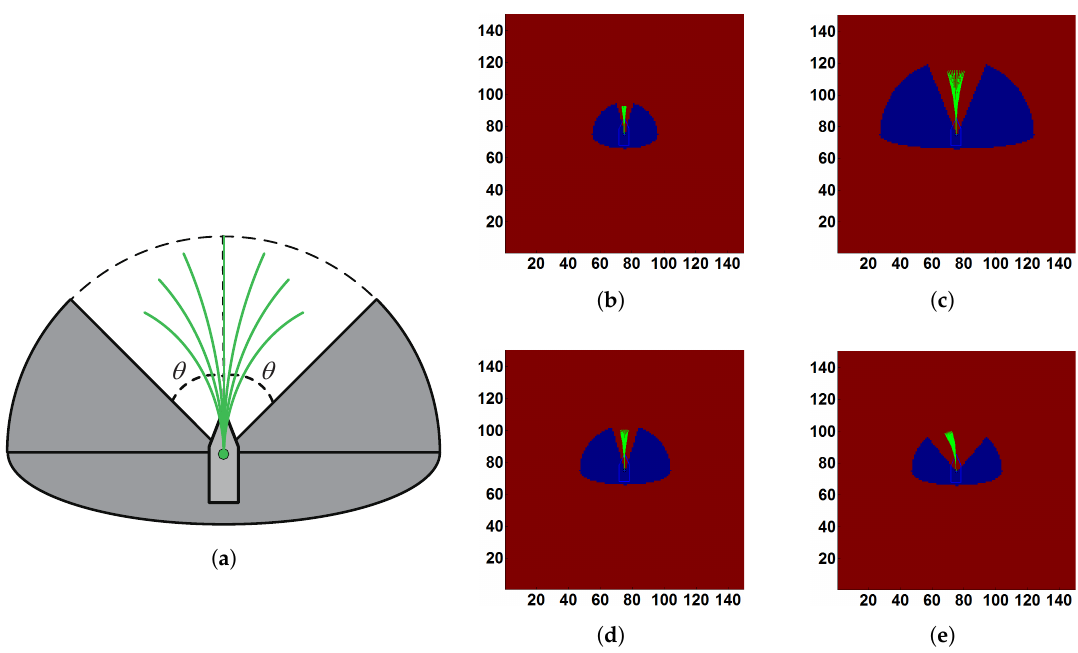
Figure 12. The own vessel dynamic domain model. ( a ) Schematic of the own vessel dynamic domain model; ( b ) The pixel image of domain model with speed 2.5 m/s and included angle of reachable area 2 × θ = 29.0 ◦ ; ( c ) Speed 10 m/s and 2 × θ = 44.5 ◦ ; ( d ) Speed 5 m/s and 2 × θ = 33.5 ◦ ; ( e ) Speed 5 m/s and 2 × θ = 57.0 ◦ . 2 × θ : the included angle of reachable